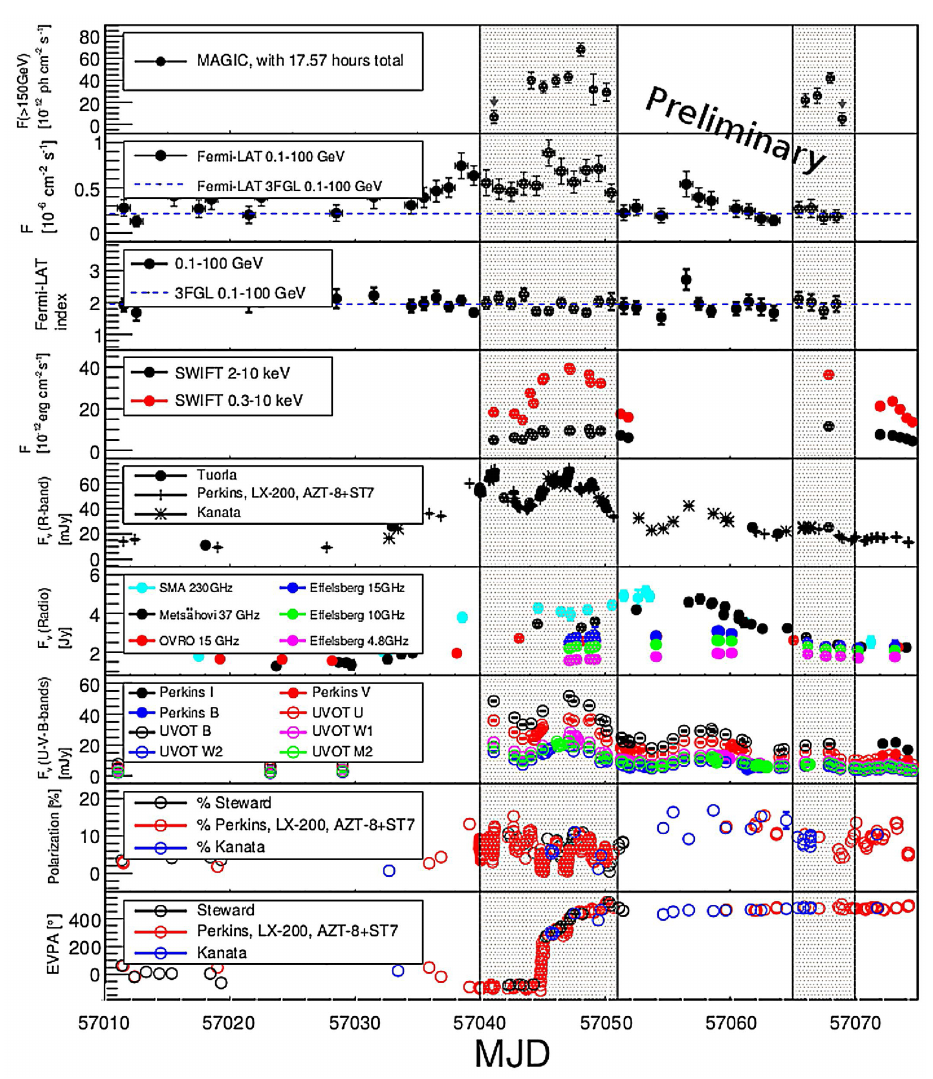
Figure 2. Multiwavelength light curves of S5 0716+714. Shadowed areas indicate Phase A (from MJD 57040 to MJD 57050) and Phase B (from MJD 57066 to MJD 57069) and the respective activities in all the energy bands. Fermi -LAT panels (second and third from the top) show the 3FGL averaged flux and spectral index from the 3FGL Catalog [20], respectively, as blue dashed